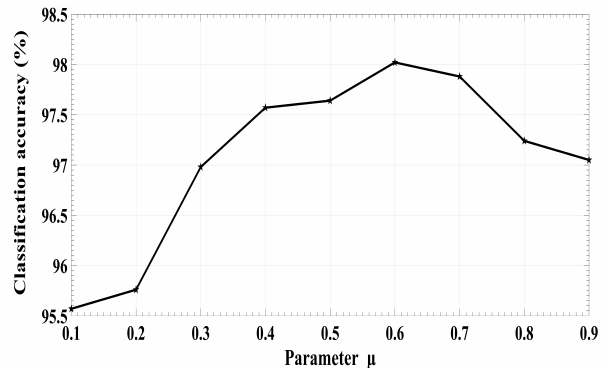
Figure 6. Classification performance of the proposed MDFR framework with different parameter µ .